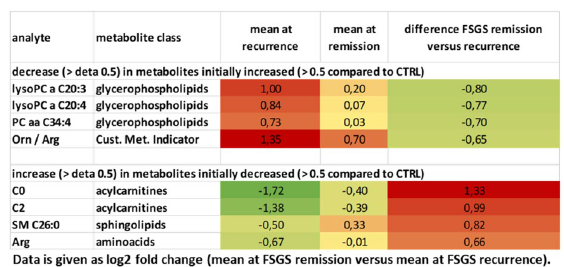
Table 3. Difference in serum metabolites in FSGS remission versus recurrence measured by mass spectrometry. Table shows metabolites that were initially increased > 0.5 and decreased more than > 0.5 as well as metabolites that were initially decreased and increased more than > 0.5. All values are given as log2 (FSGS patient/stable transplanted control). The mean of two measurements at the time of FSGS relapse (before and after the 1. CytoSorb apheresis) to the mean of two measurements at the time of FSGS remission (before and after the CytoSorb apheresis at stable remission) were used for